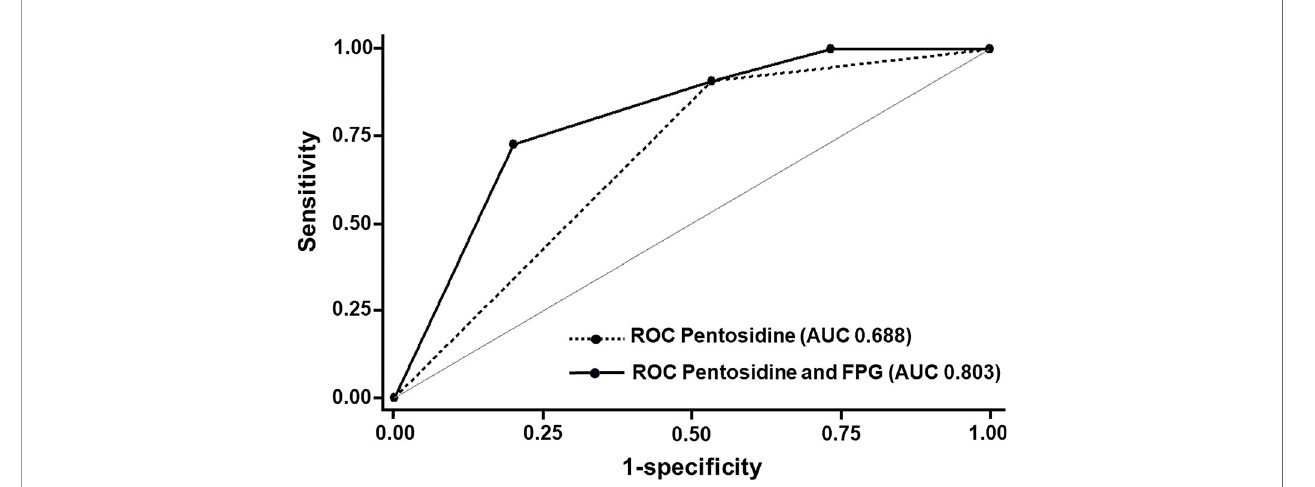
FIGURE 3 | ROC and Area under ROC (AUC) for the Prediction of the expression of AGER. With s erum pentosidine at the cut-off level of 2.1 ng/ml, the AUC of serum pentosidine to predict the expression of AGER was 0.688. With the combination of both serum pentosidine at the cut-off level of 2.1 ng/ml and fasting plasma glucose at the cut-off level of 100 mg/dl into the model, the AUC signi fi cantly increased from 0.688 to 0.803 (0.803 vs 0.688, p =